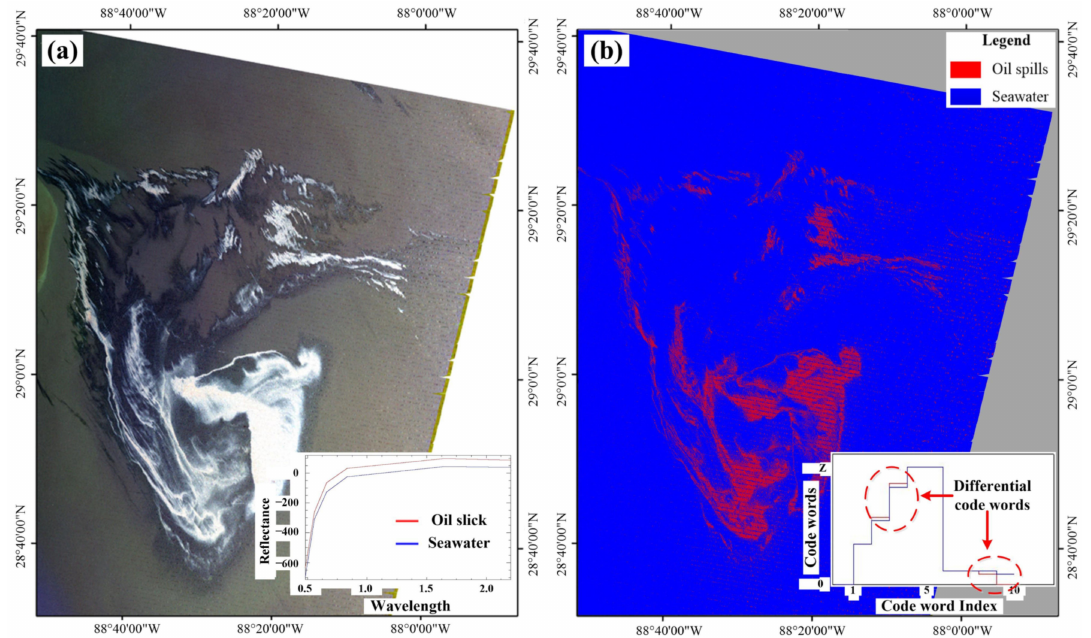
Figure 5. The experimental data 1 (( a ), captured by the Landsat 7 satellite) and its crude oil leakage detection results produced by the MSE method with SSI ( b ). Differential code words could be observed in the red